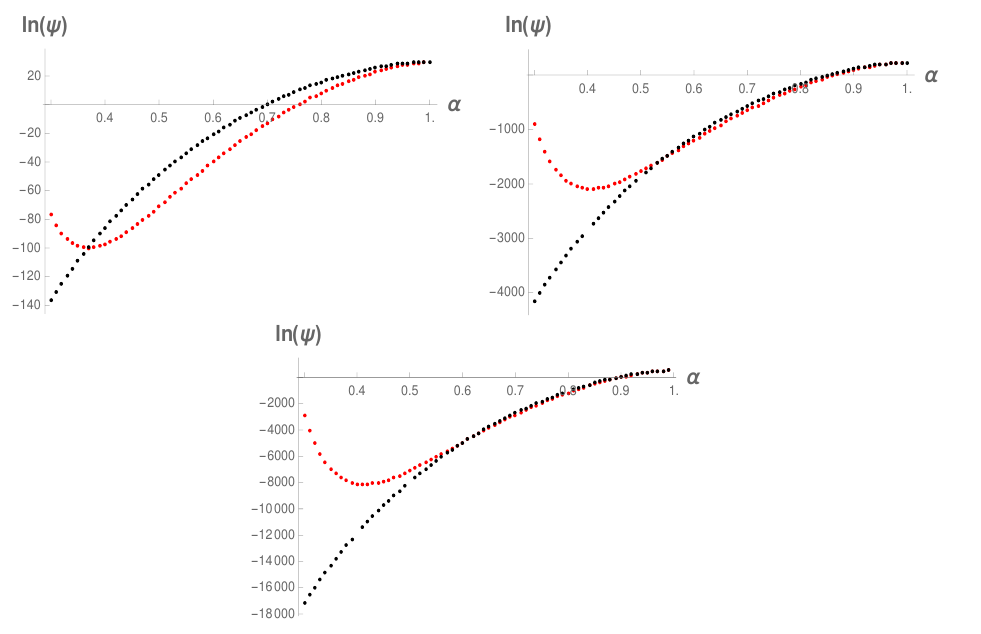
Figure 2 . Comparison of eq. (6.12) (red) versus the exact matrix elements calculated using the Van- dermonde formula (6.3) (black) at N = 20 (top left), N = 100 (top right) and N = 200